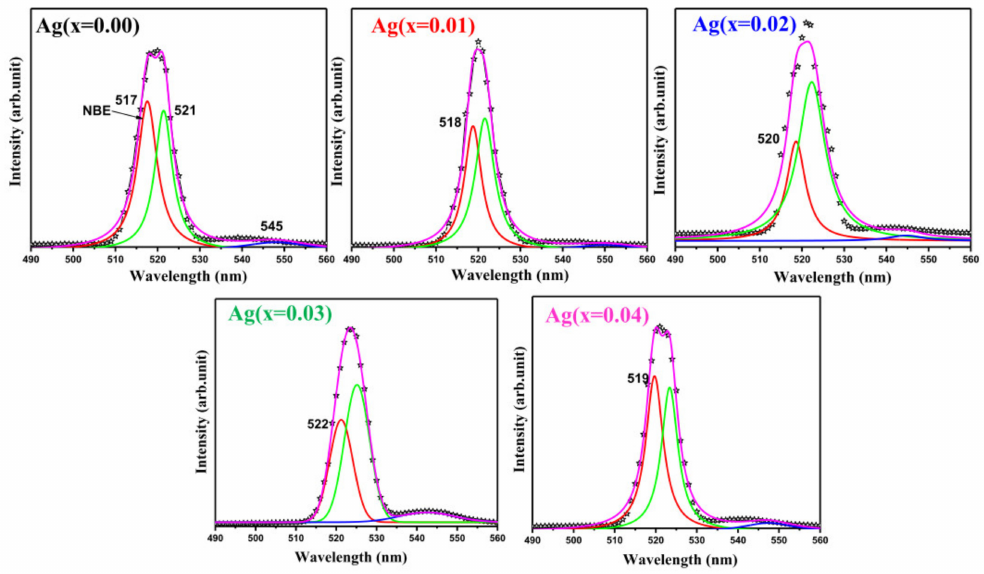
Figure 4. Gaussian curve-fitted photoluminescence spectra of pure and Ag-doped CdO thin